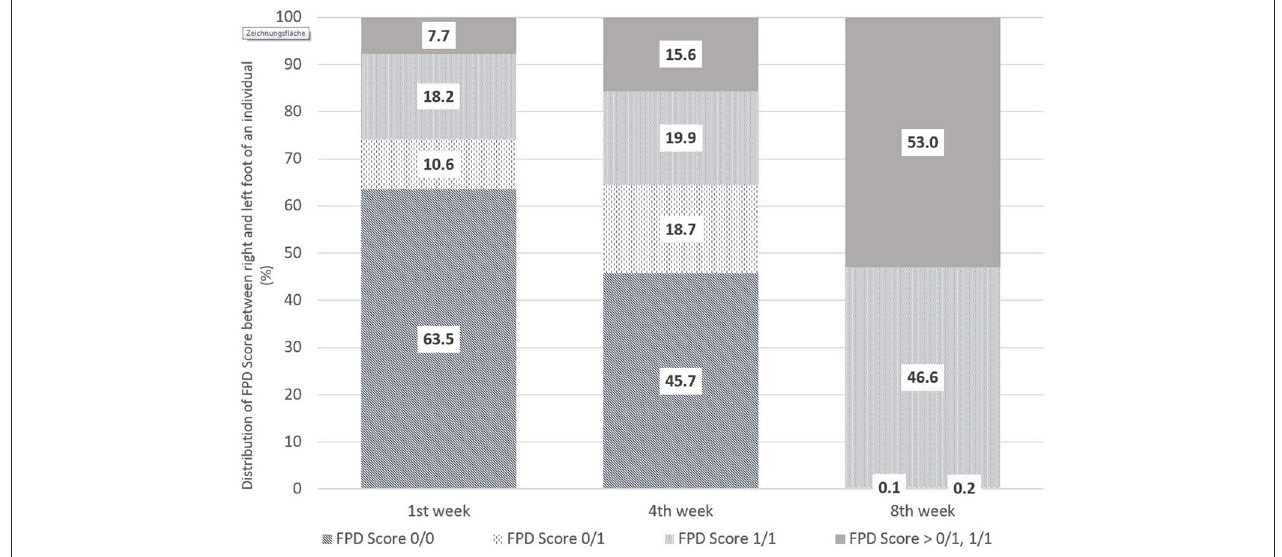
FIGURE 1 | Comparison of FPD-Scores between the right and left foot of an individual bird from the first to eighth week of life in % [ n = 1,382 pairs (1st week), 1,681 pairs (4th week), 2,013 pairs (8th week)] (where Score 0/0 means no FPD on left and right foot; 0/1 one foot of the pair with FPD Score 1 and the other Score 0, 1/1 both feet with FPD Score 1 and > 0/1;1/1 stands for at least one foot of an individual worse than Score